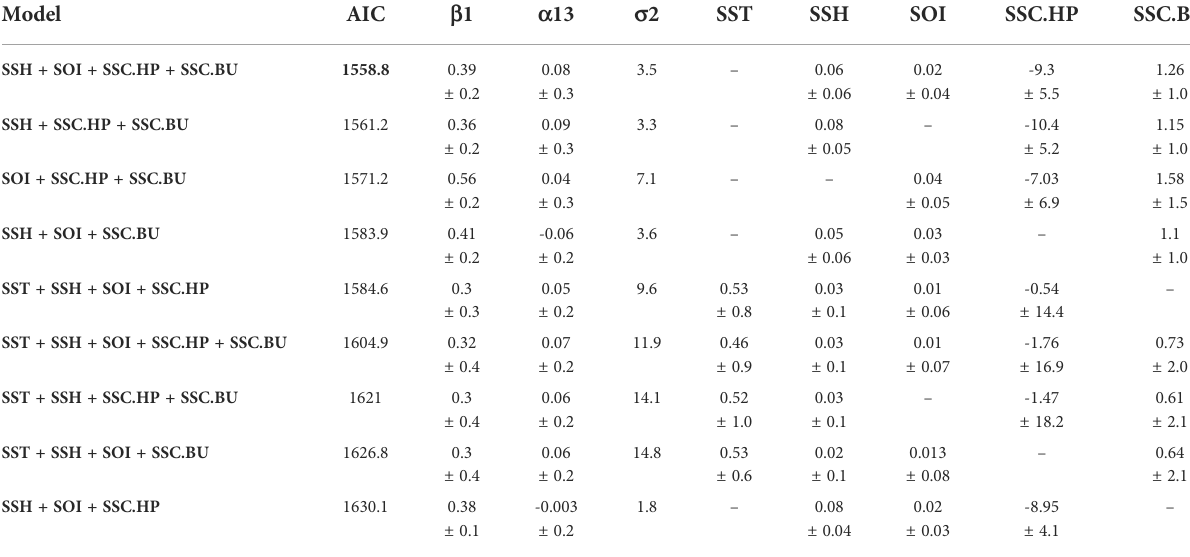
TABLE 2 Multivariate model selection with all variables and whale call detection counts as the dependent variable using a count time series analysis. Model SOI + SSC.HP + SSC.BU